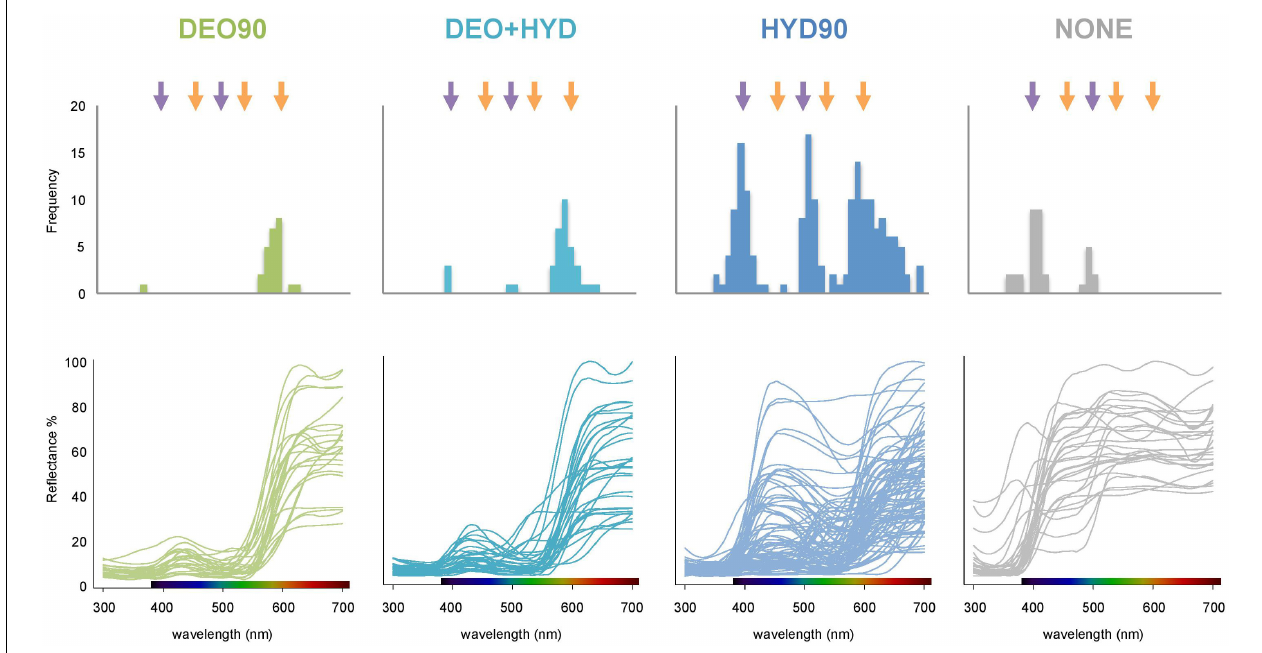
FIGURE 6 | Marker point distribution (top panel) and the reflectance curves (bottom panel) of HYD90 ( > 90% HYD; blue), DEO90 ( > 90% DEO; green), DEO+HYD (both DEO and HYD between 10 and 90%; cyan) and no-anthocyanin (NONE; gray) flowers. Purple arrows at 400 and 500 nm represent the hue-discrimination optima for bees, and orange arrows at 460, 540, and 600 nm represent the hue-discrimination optima for hummingbirds. The color panels on the x-axes of the reflectance plots represent the visible light